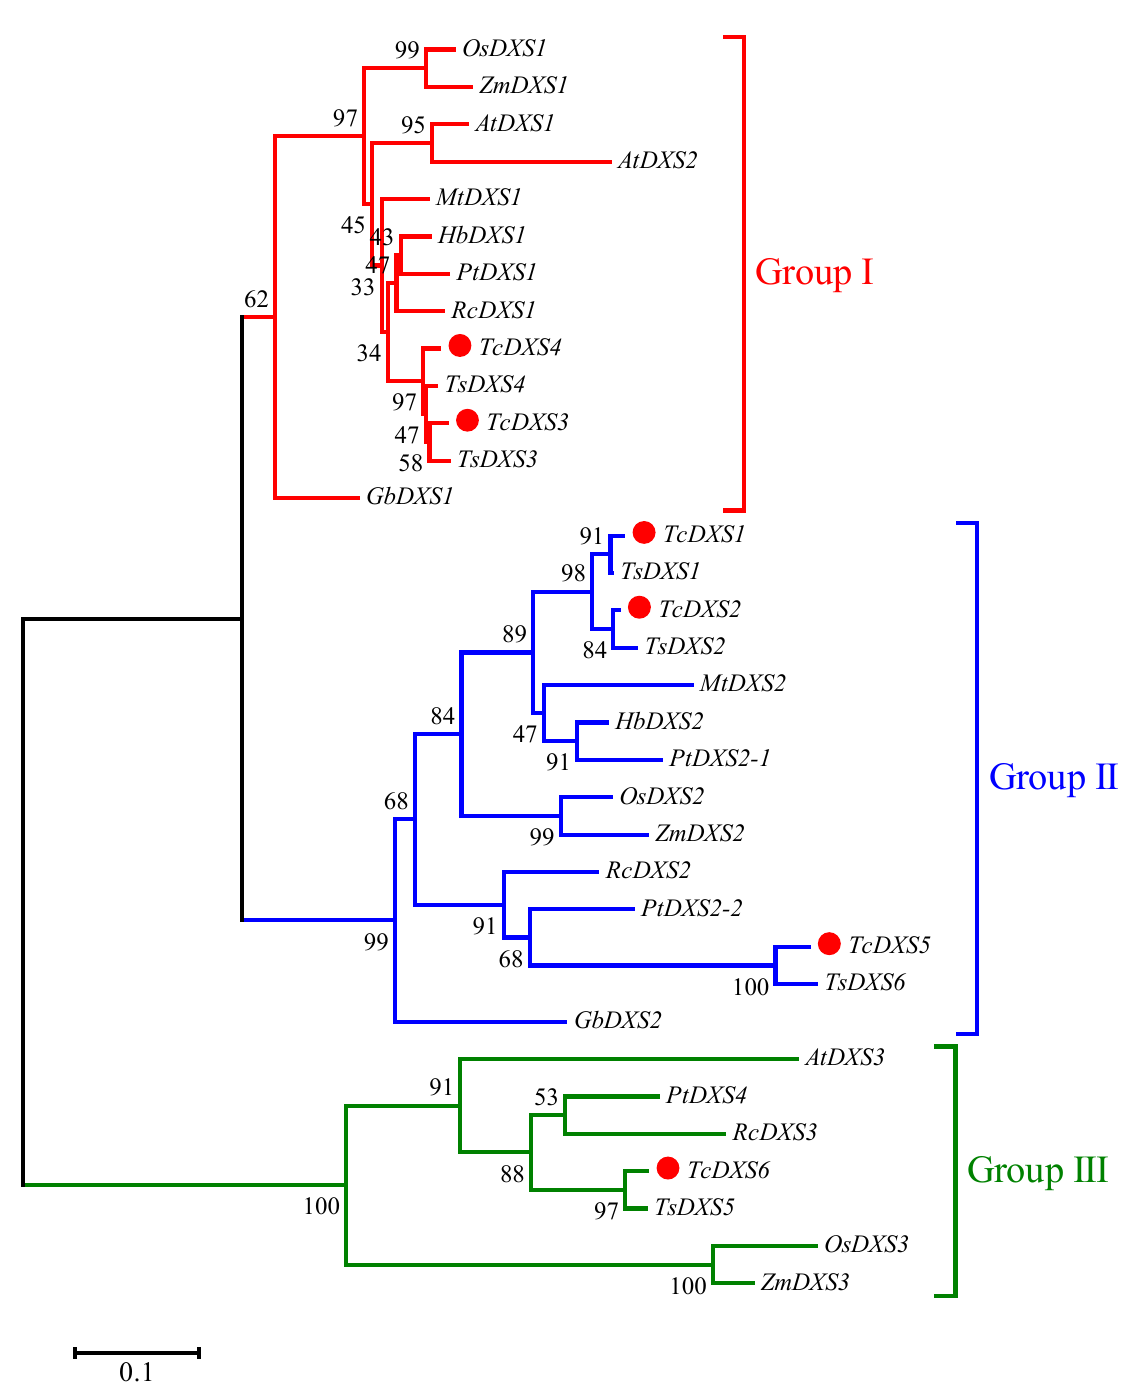
Figure 1. Phylogenetic tree of the DXS gene family from T. ciliata , A. thaliana , G. biloba , H. brasiliensis , M. truncatula , O. sativa , P. trichocarpa , R. communis , T. sinensis , and Z. mays . A neighbor-joining tree was constructed from DXSs’ protein sequences (Table S1).